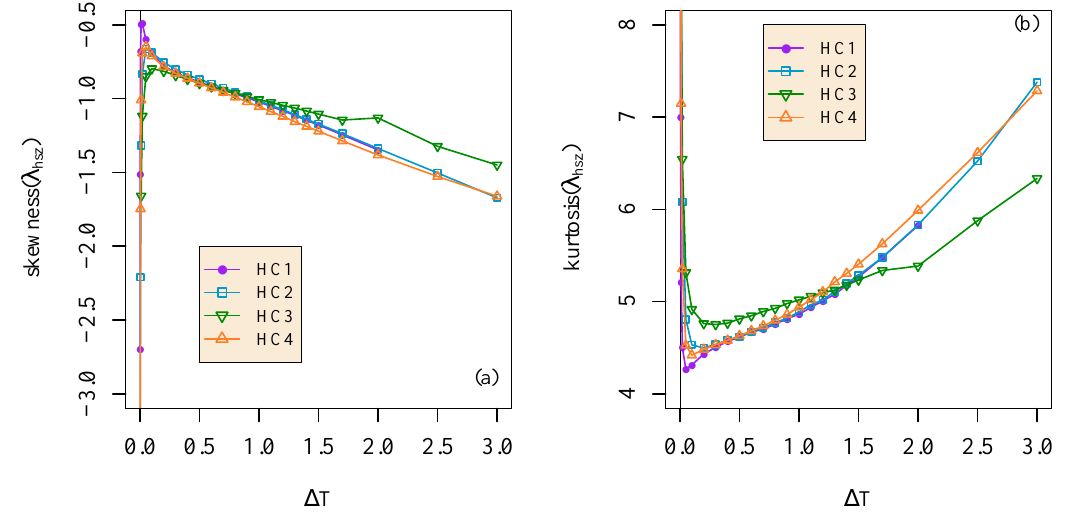
Figure 12. Skewness ( a ) and kurtosis ( b ) of λ hsz vs. temperature separation for simulations HC1, HC2, HC3, and